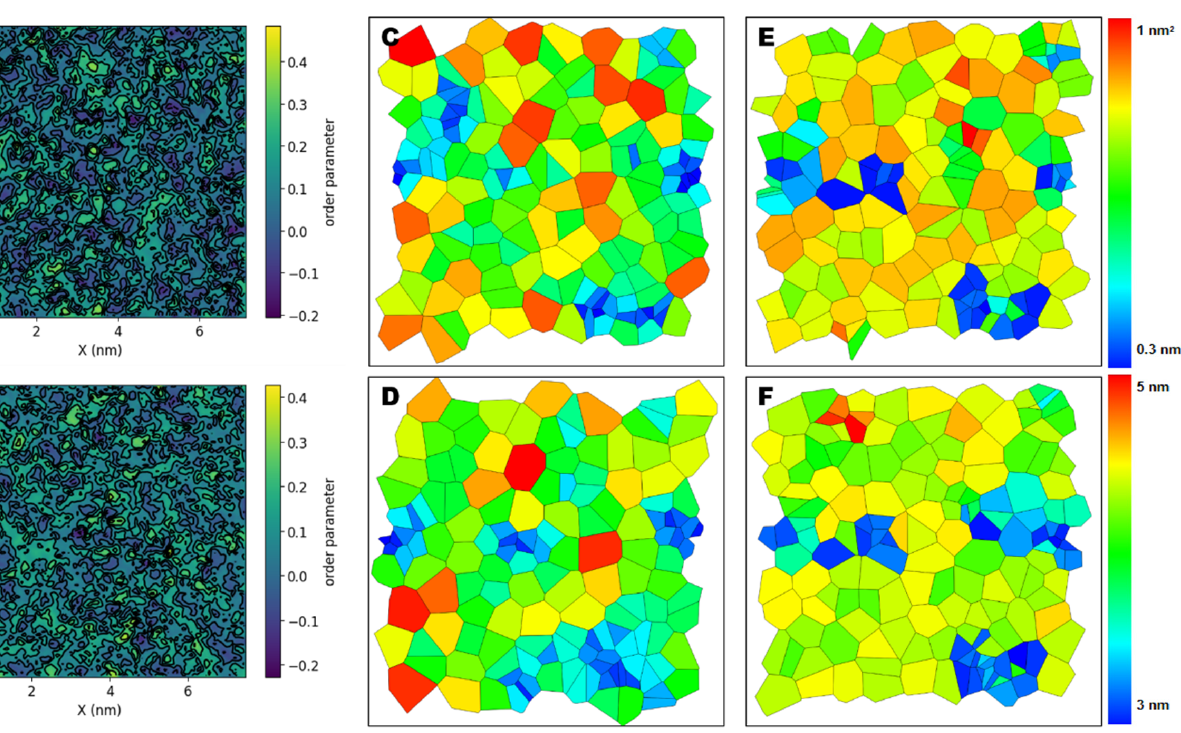
Figure 5. NPs alter the equilibrium properties of lipid bilayers. ( A , B ) Membrane order landscape for model membranes containing and not containing PVC10 NPs, respectively. ( C , D ) Voronoi analysis of x – y projections of the center of mass of the lipids used to obtain area per lipid values in membranes containing and not containing PVC10 NPs. ( E , F ) Voronoi analysis of x – y projections of the center of mass of the lipids were used to obtain the thickness per lipids in membranes containing and not containing PVC10 NPs. The colormaps were scaled differently in these images to illustrate the different values.